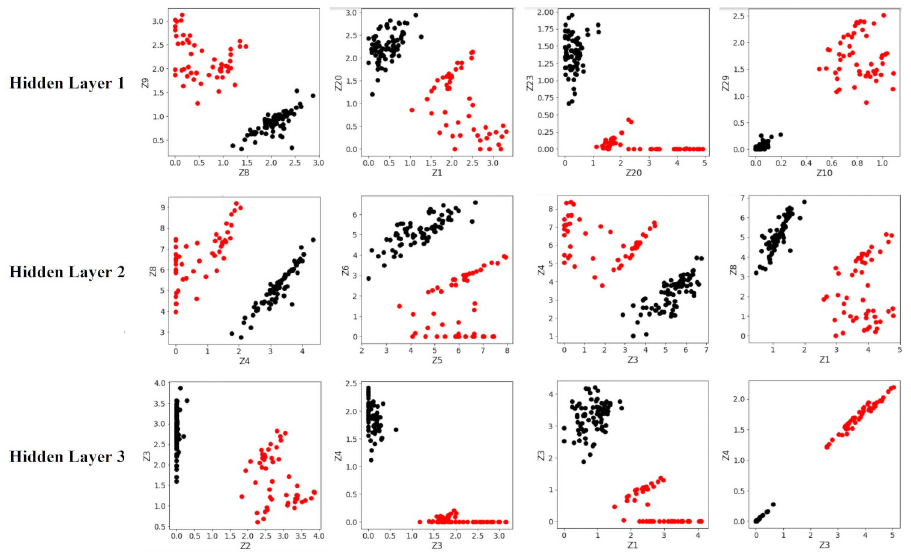
Fig 15. Inter-class separations in the traditional ANN. Black samples belong to the undisturbed class. Red samples belong to the disturbed class. Only the first 4 out of the total 5000 runs are shown.